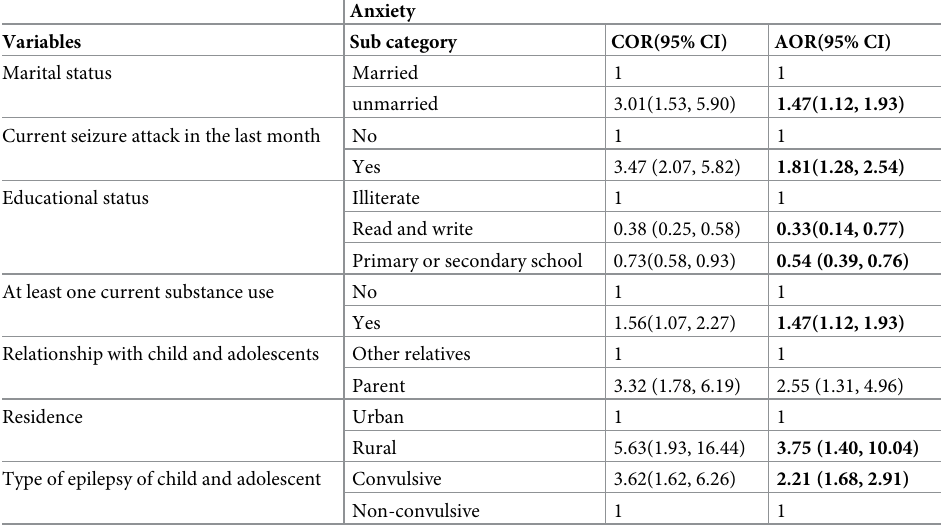
Table 4. Bivariate and multivariate analysis of factors associated with anxiety among caregivers of children and adolescents with epilepsy attending follow up visits in the three hospital (n =